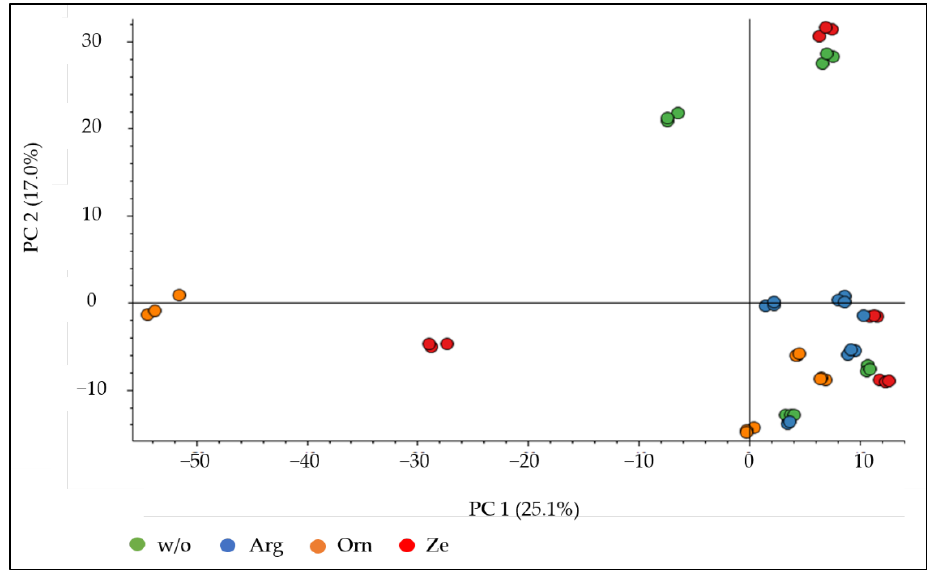
Figure 2. Principal component analysis plot of the urine proteome of cats ( n = 4) fed a high-protein diet without (w/o) or with the supplementation of arginine (Arg), ornithine (Orn) or zeolite (Ze). The plot depicts the triplicate determination for each cat and feeding group. Table 7. KEGG pathways 1 related to downregulated urinary proteins of cats fed a high-protein diet with an arginine supplementation compared to cats without a dietary supplementation.